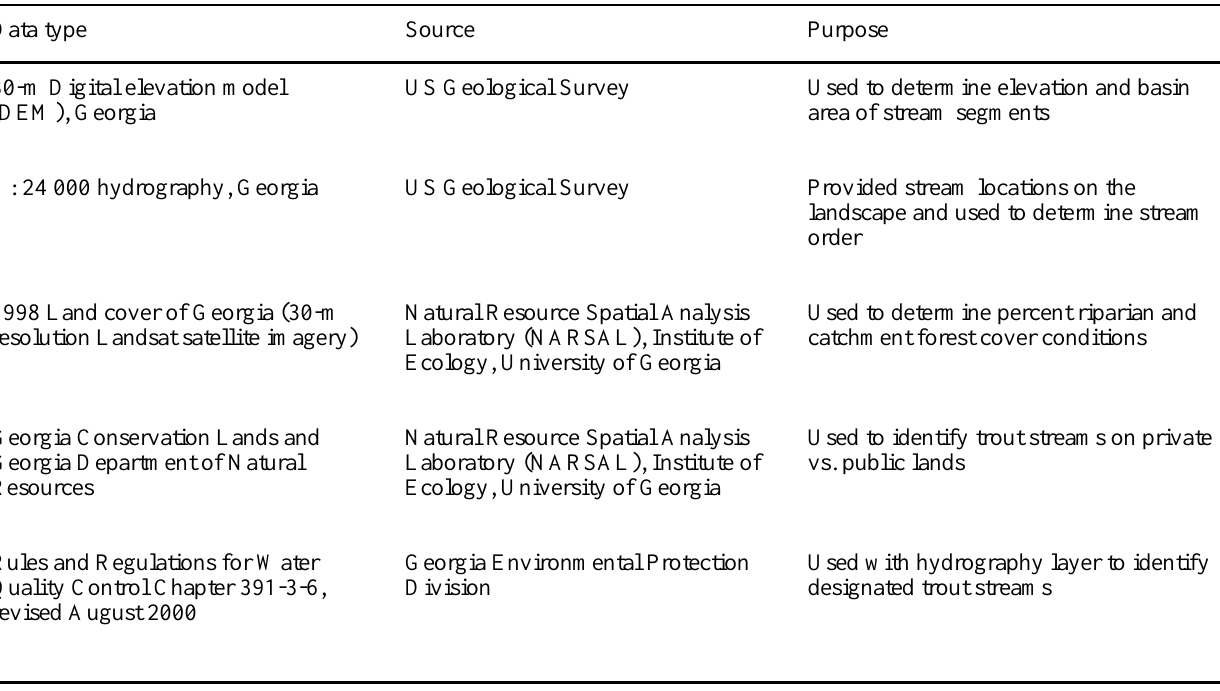
Table 2. Base data layers included in the Trout Stream GIS